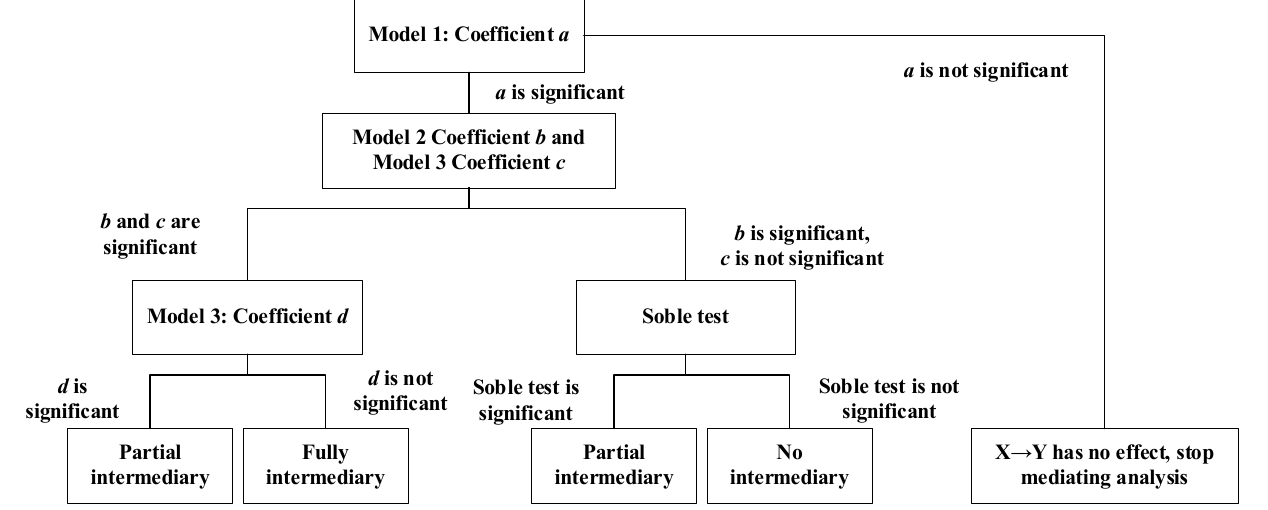
Figure 1. Construction of Psychological Empowerment Mediation Model.